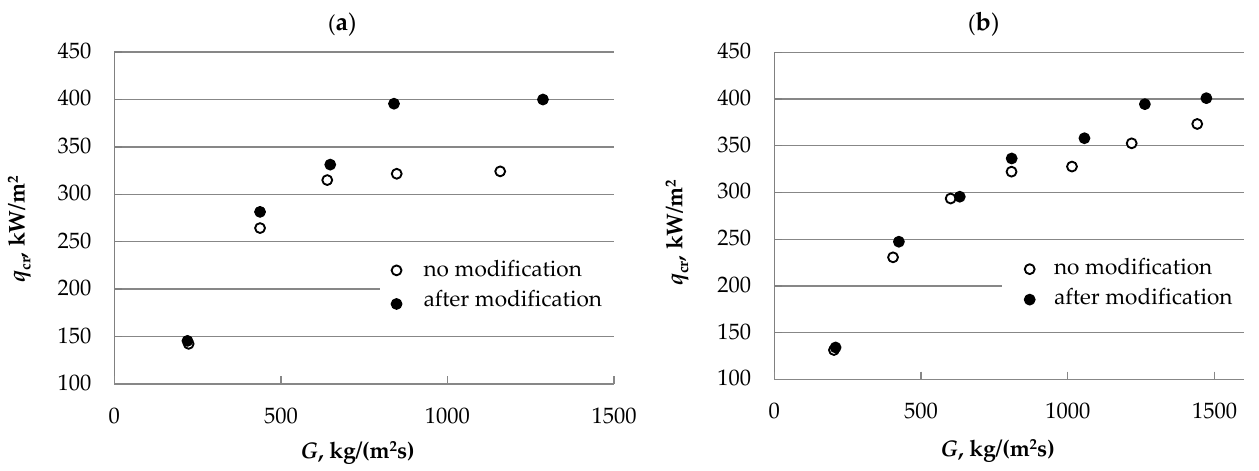
Figure 11. CHF data versus mass flow rate, ( a ) p r = 0.43, ( b ) p r = 0.56.